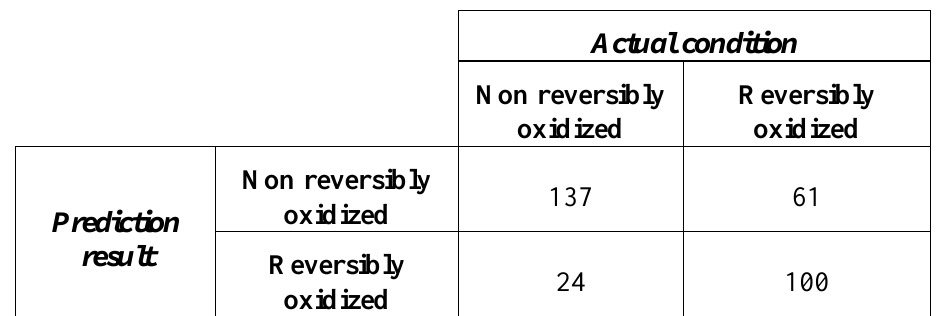
Tab. 1: Result from testing ROCD on